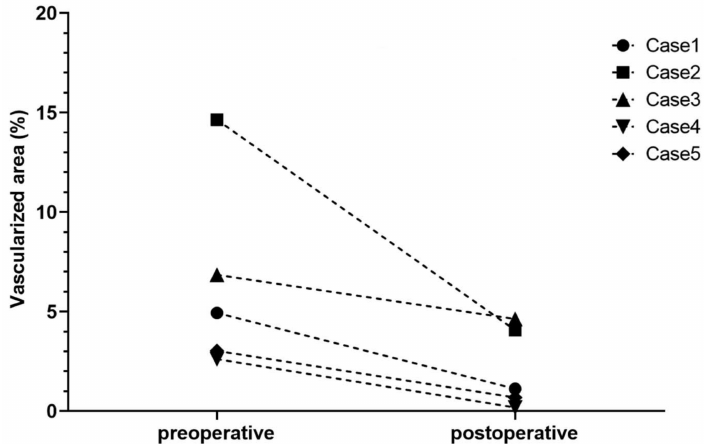
Figure 10. Reduction of corneal neovascularization by peripheral CXL before high-risk PK. In case 1, 1 peripheral CXL was first performed as a single procedure, followed by an additional peripheral CXL procedure combined with keratoplasty. In cases 2 to 5, the peripheral CXL procedure was directly combined with keratoplasty (without previous peripheral CXL). Corneal neovascularization was morphometrically measured as the corneal area covered by blood vessels in relation to the total corneal area. Morphometrical analysis revealed a neovascularization reduction of 70.5 ± 22.7%. From Schaub et al. 2018